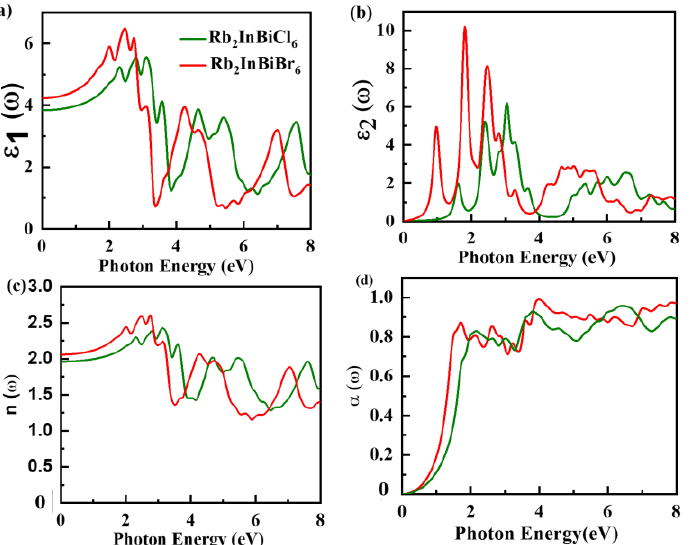
Figure 6. Computed ( a ) real part ε 1 ( ω ), ( b ) imaginary part ε 2 ( ω ) of dielectric, ( c ) refractive index n ( ω ), ( d ) absorption coefficient α ( ω ) for Rb 2 InBiX 6 (X = Cl, Br) compounds. Table 4. Calculated optical and transport properties for double perovskite Rb 2 InBiX 6 (X = Cl, Br) compounds using mBJ